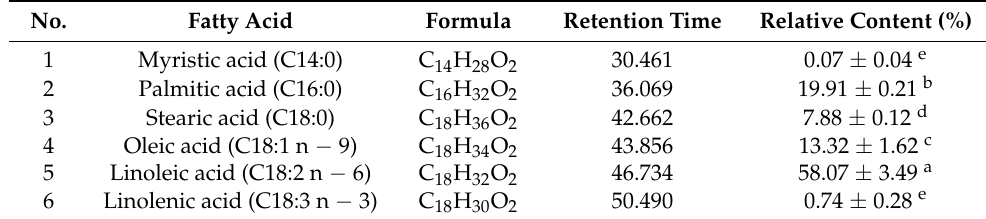
Table 3. Fatty acid composition of vanilla essential